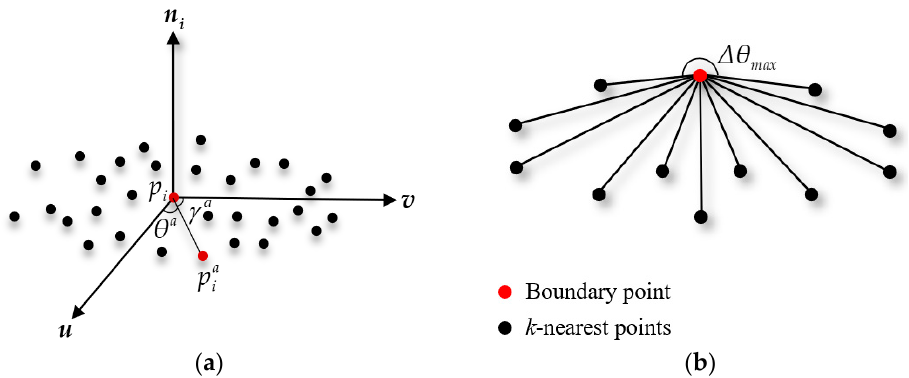
Figure 2. Basic principle of boundary extraction. ( a ) The point-neighborhood evaluation method; ( b ) An illustration of a boundary point.